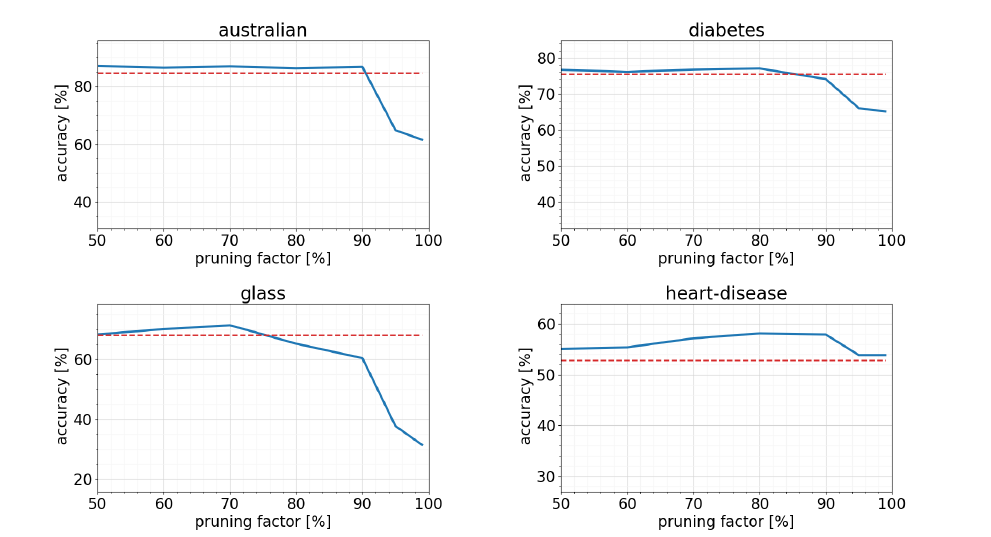
Figure 11. Results of pruning MLP ANN structure on Australian, diabetes, glass and heart-disease datasets.